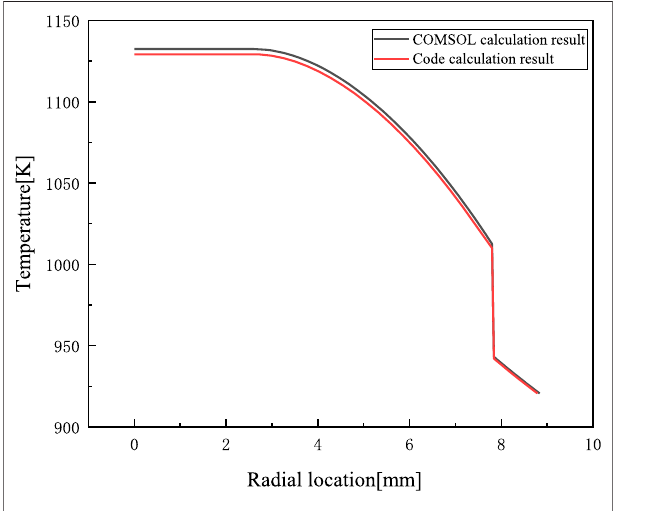
FIGURE 5 | The comparison of temperature between the calculation results of code and COMSOL.